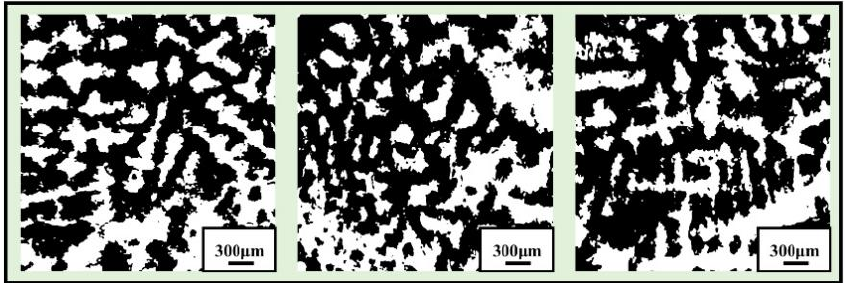
Table 2. SDAS and fractal dimensions ( D ) of three repeated experiments .